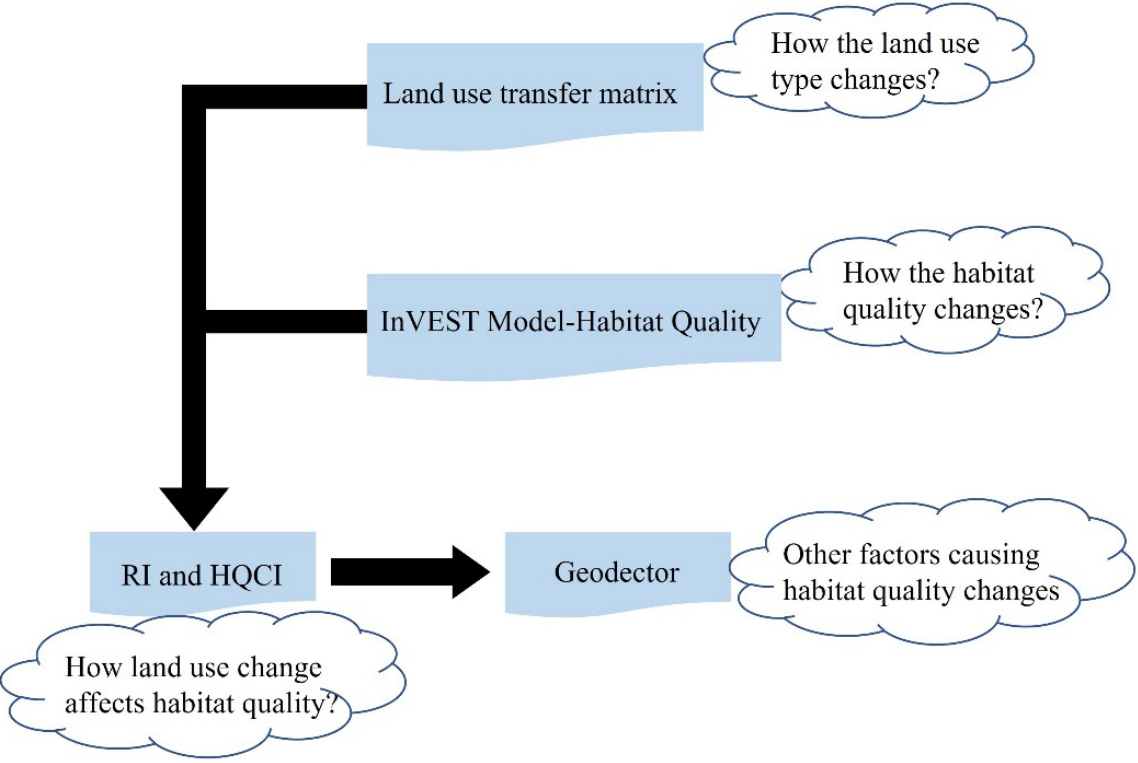
Figure 2. Methods and processes.